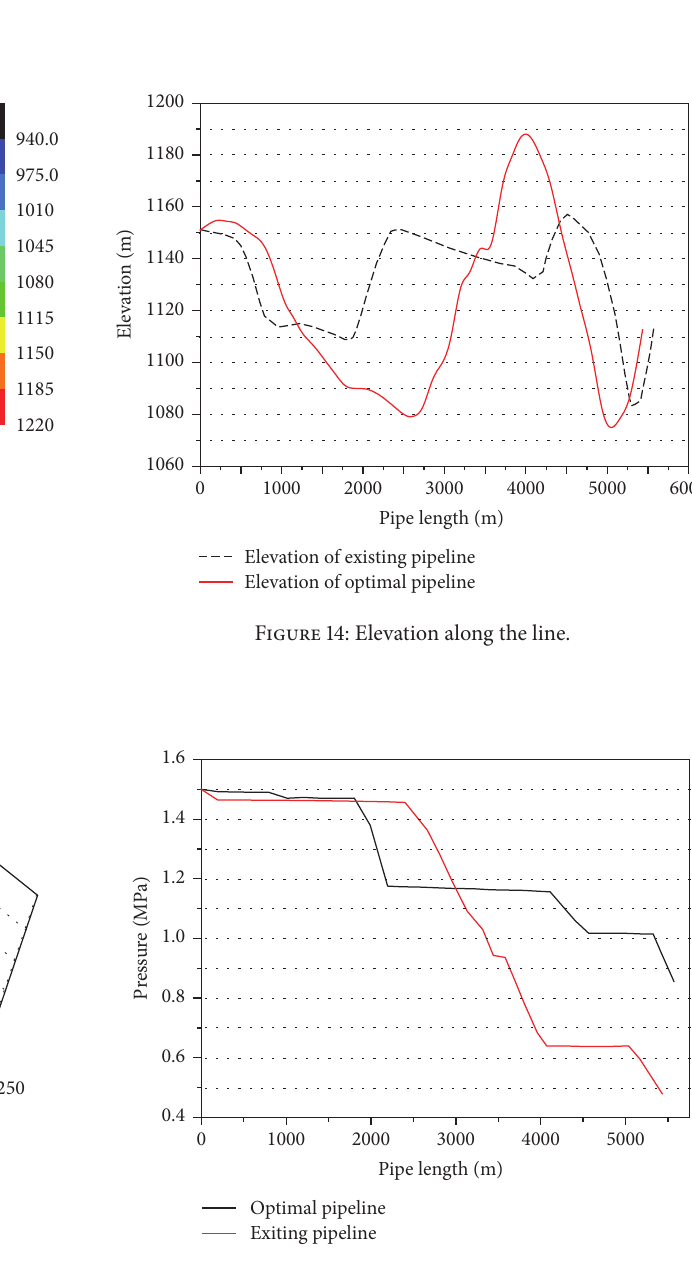
Figure 15: Pressure along the